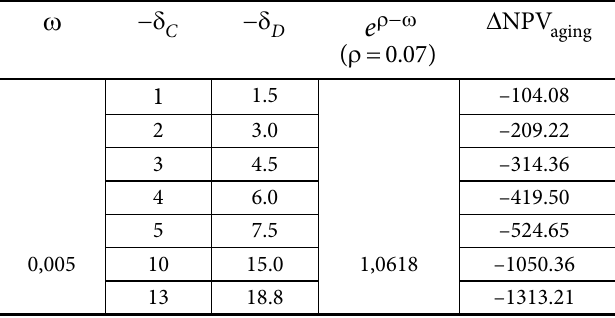
Table 2. The differences in NPV between the activities without reduced quality and perturbations in the production lead times and the examples in which perturbed delays at C and D appear as 30% of the initial value and the quality of production influence the prices of items by